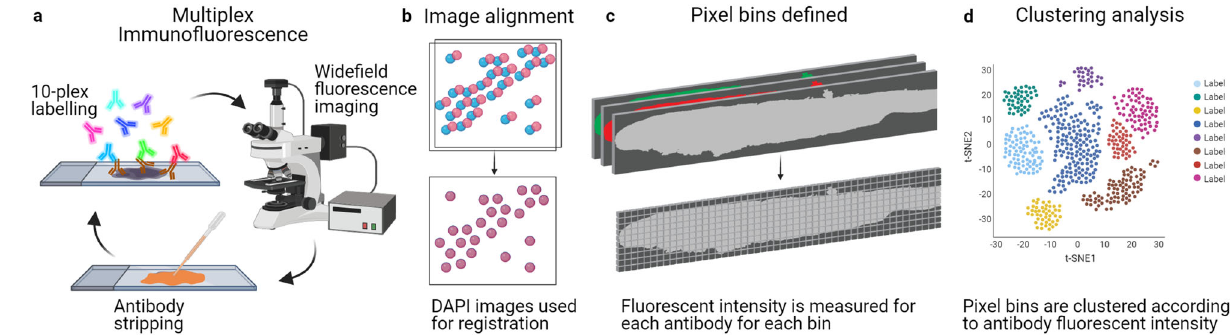
Fig. 1 MP-IHC and spatial protein analysis methodology. a Sections were labelled using iterative rounds of 10-plex fl uorescent immunohistochemistry, imaging and antibody stripping. b The images from each labelling round were manually aligned in photoshop using the DAPI channel from each round as a reference. c The aligned images were imported into R, and 10 × 10 μ m pixel bins were calculated with the x-y coordinates of each bin captured. The fl uorescence intensity of each antibody label was measured for each pixel bin. d Spatial protein analysis was performed using R and the Seurat library to generate UMAP plots of bin clusters and identify differential markers between disease groups. Created with